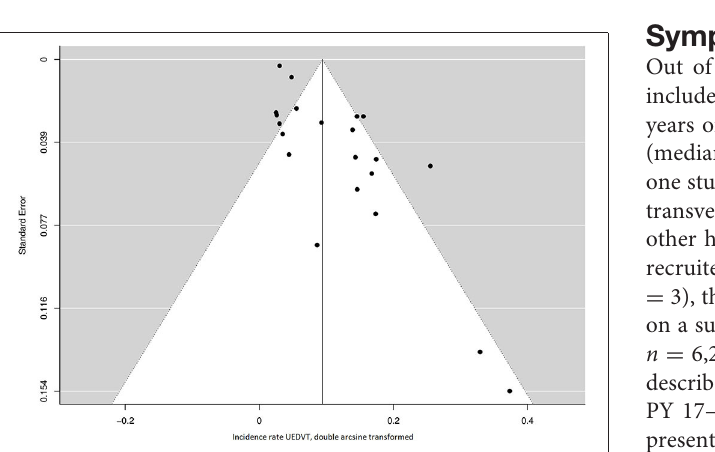
(38–49) and 12 report both outcomes (50–61). No additional eligible reports were identified from a hand search of the included articles’